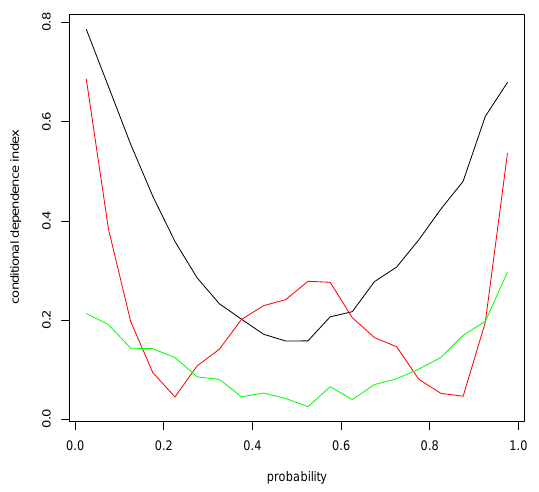
Figure 5. Full Sample Conditional Dependence Index Estimates (black: rvix | rsp; red: VIX 2 | rsp; green: rsp | VIX 2